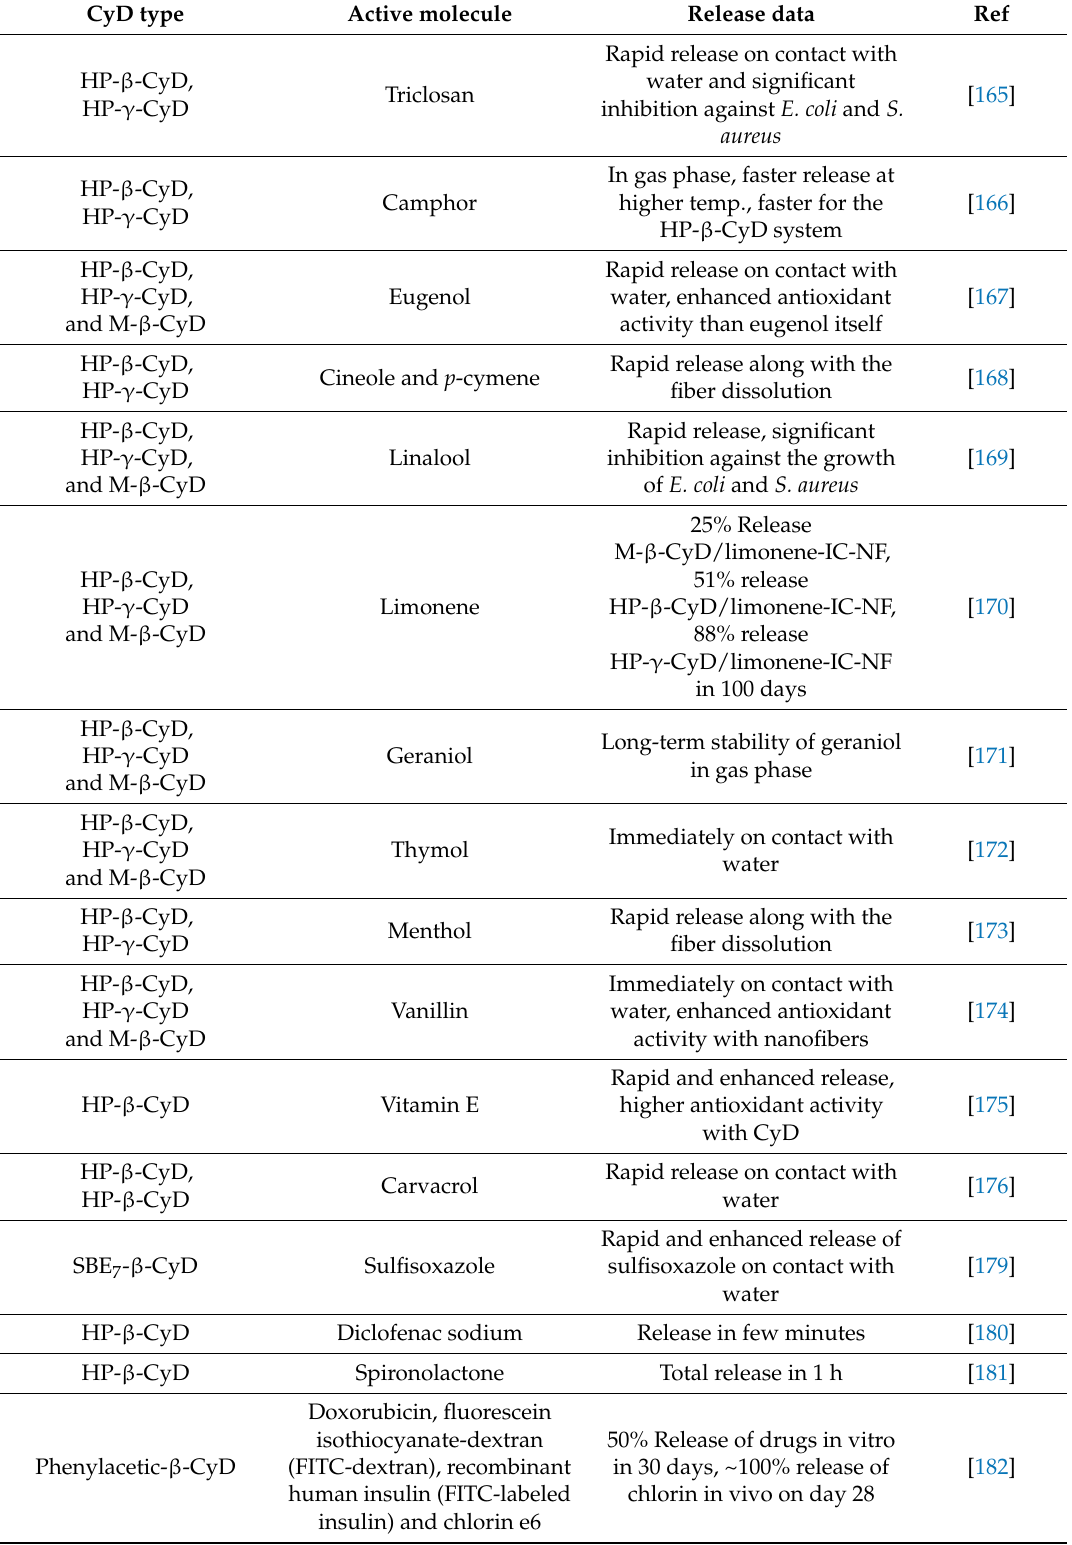
Table 3. Overview of polymer-free CyD/drug ICs electrospun nanofibers used in drug